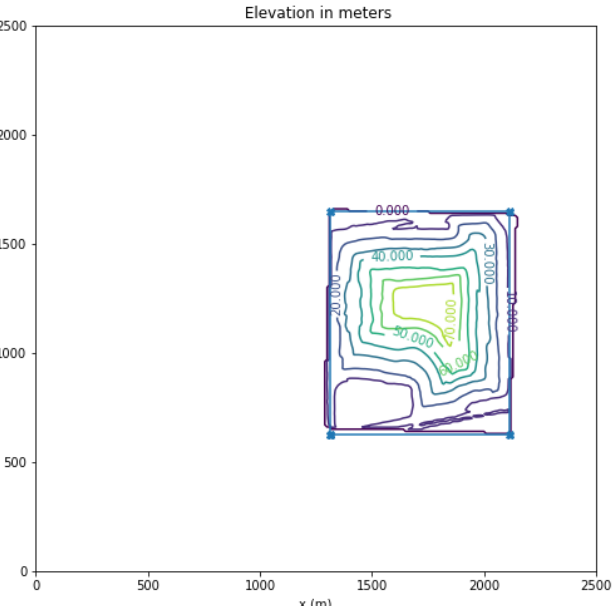
Figure 1. Model domain and terrain elevation above local background for Facility A. Blue line is approximate border of the landfill.